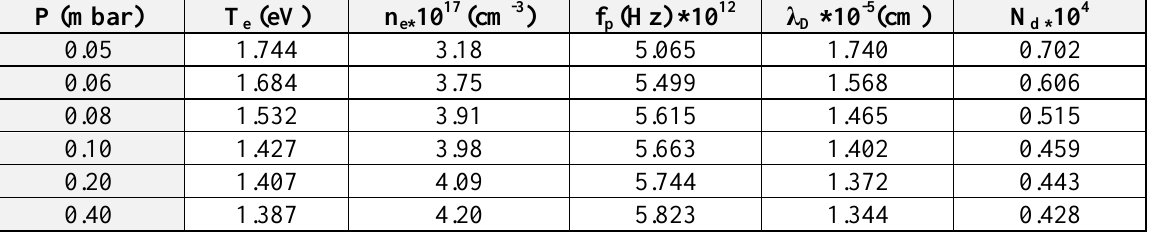
Table 2: Plasma parameters for RF plasma in oxygen with different working